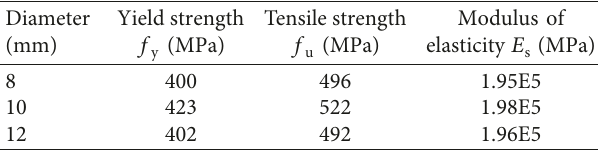
Table 2: Mechanical properties of the reinforcing bars.